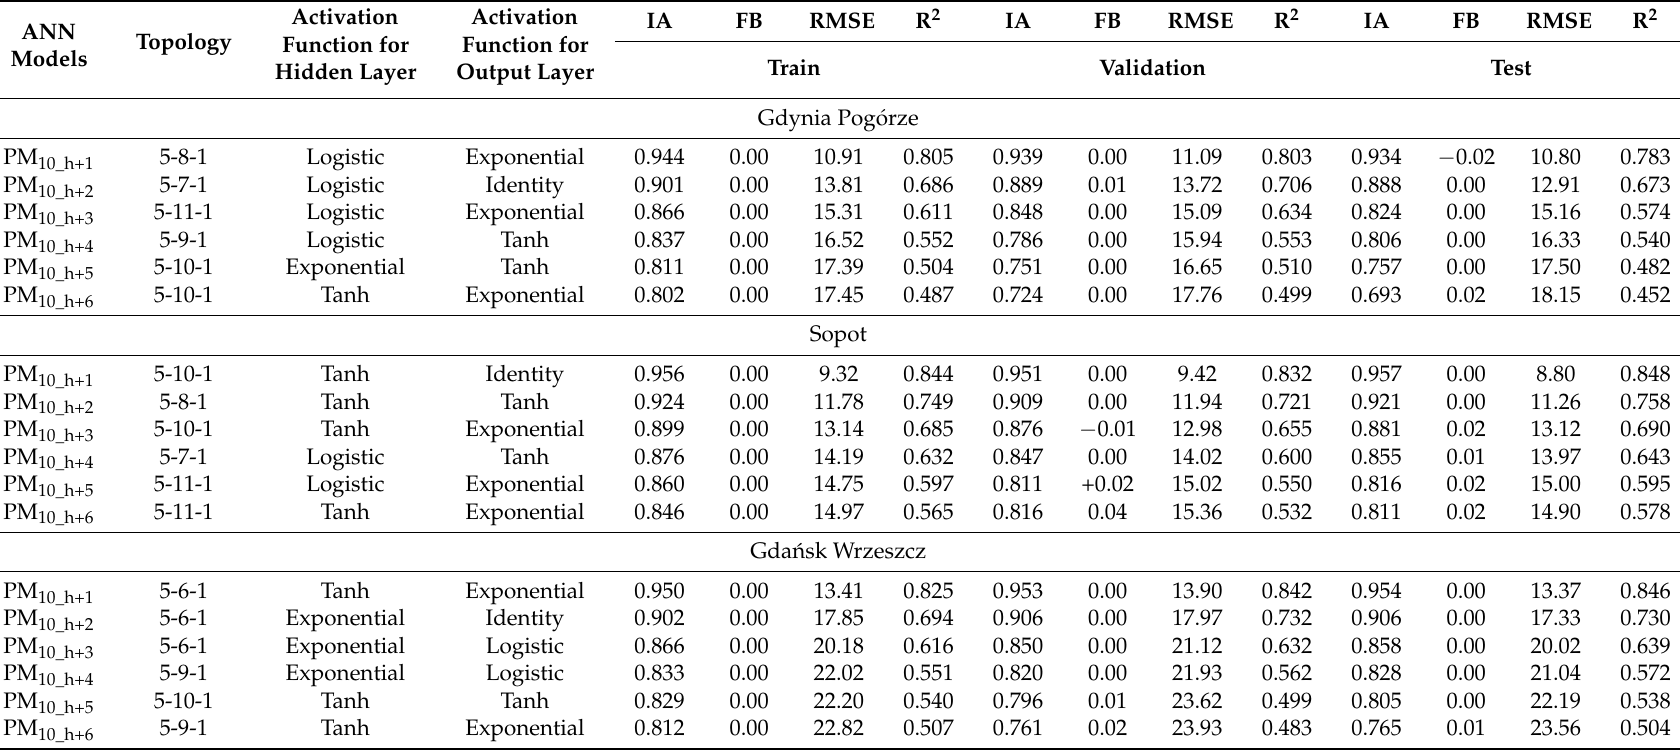
Table 2. The statistics for the best performing ANN models for the forecasting of hourly concentrations of PM 10